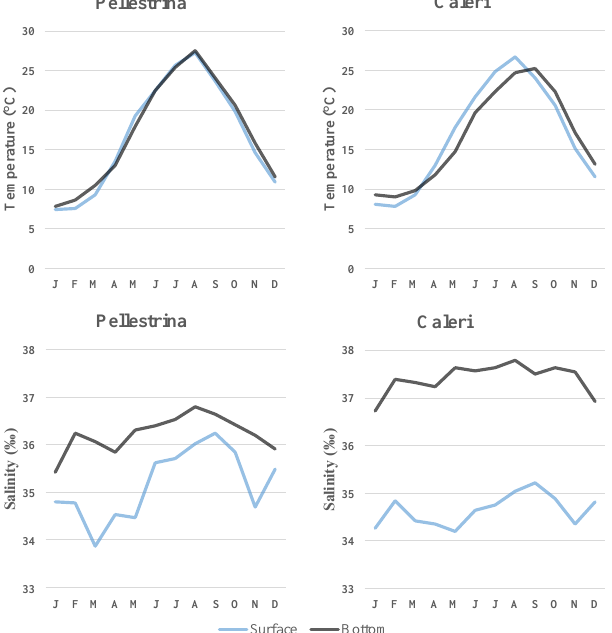
Figure 7. Mean monthly values of temperature and salinity at Pellestrina and Caleri. Data from E.U. Copernicus Marine Service Information (CMEMS) https://marine.copernicus.eu/ accessed on 2 December 2021.